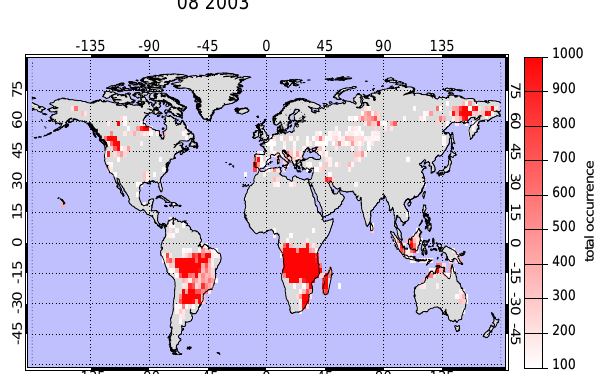
Fig. 5. A histogram of residuals (MIPAS measurements-RFM modelled radiances) from 15578 scans from August 2003 at ap- proximately 185hPa. The standard deviation of our residuals is 14nW/(cm 2 sr cm − 1 ). Note that the noise equivalent spectral ra- diance in band B of the MIPAS is below 20nW/(cm 2 sr cm − 1 ) at 1200cm − 1 , (Kleinert et al., 2007). The dashed line represents the zero point in the residual.